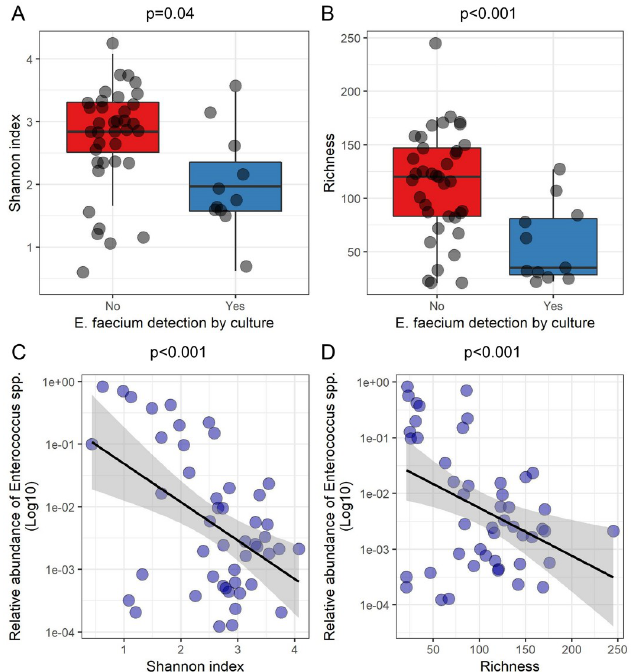
Fig 3. Enterococcus spp. and Enterococcus faecium intestinal colonization according to the composition of the intestinal microbiota (16S profiling results from 11 samples containing E . faecium ). Panels A and B: boxplot superimposed by dot-plot of Shannon diversity index (A) and richness (B) according to the detection by culture of E . faecium . Panels C and D: Dot-plot of the relative abundance of reads assigned to Enterococcus spp. (in Log10), Shannon diversity index (C) and richness (D) (n = 48 samples). The shaded grey area depicts the 95% confidence interval around the black line. Panels A and B: Student test; panels C and D: Pearson correlation test.